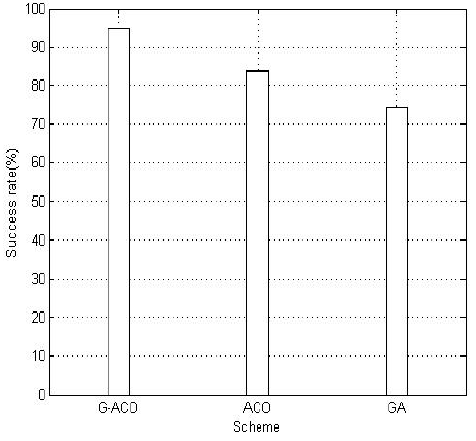
Figure 6. The comparison of success rates.